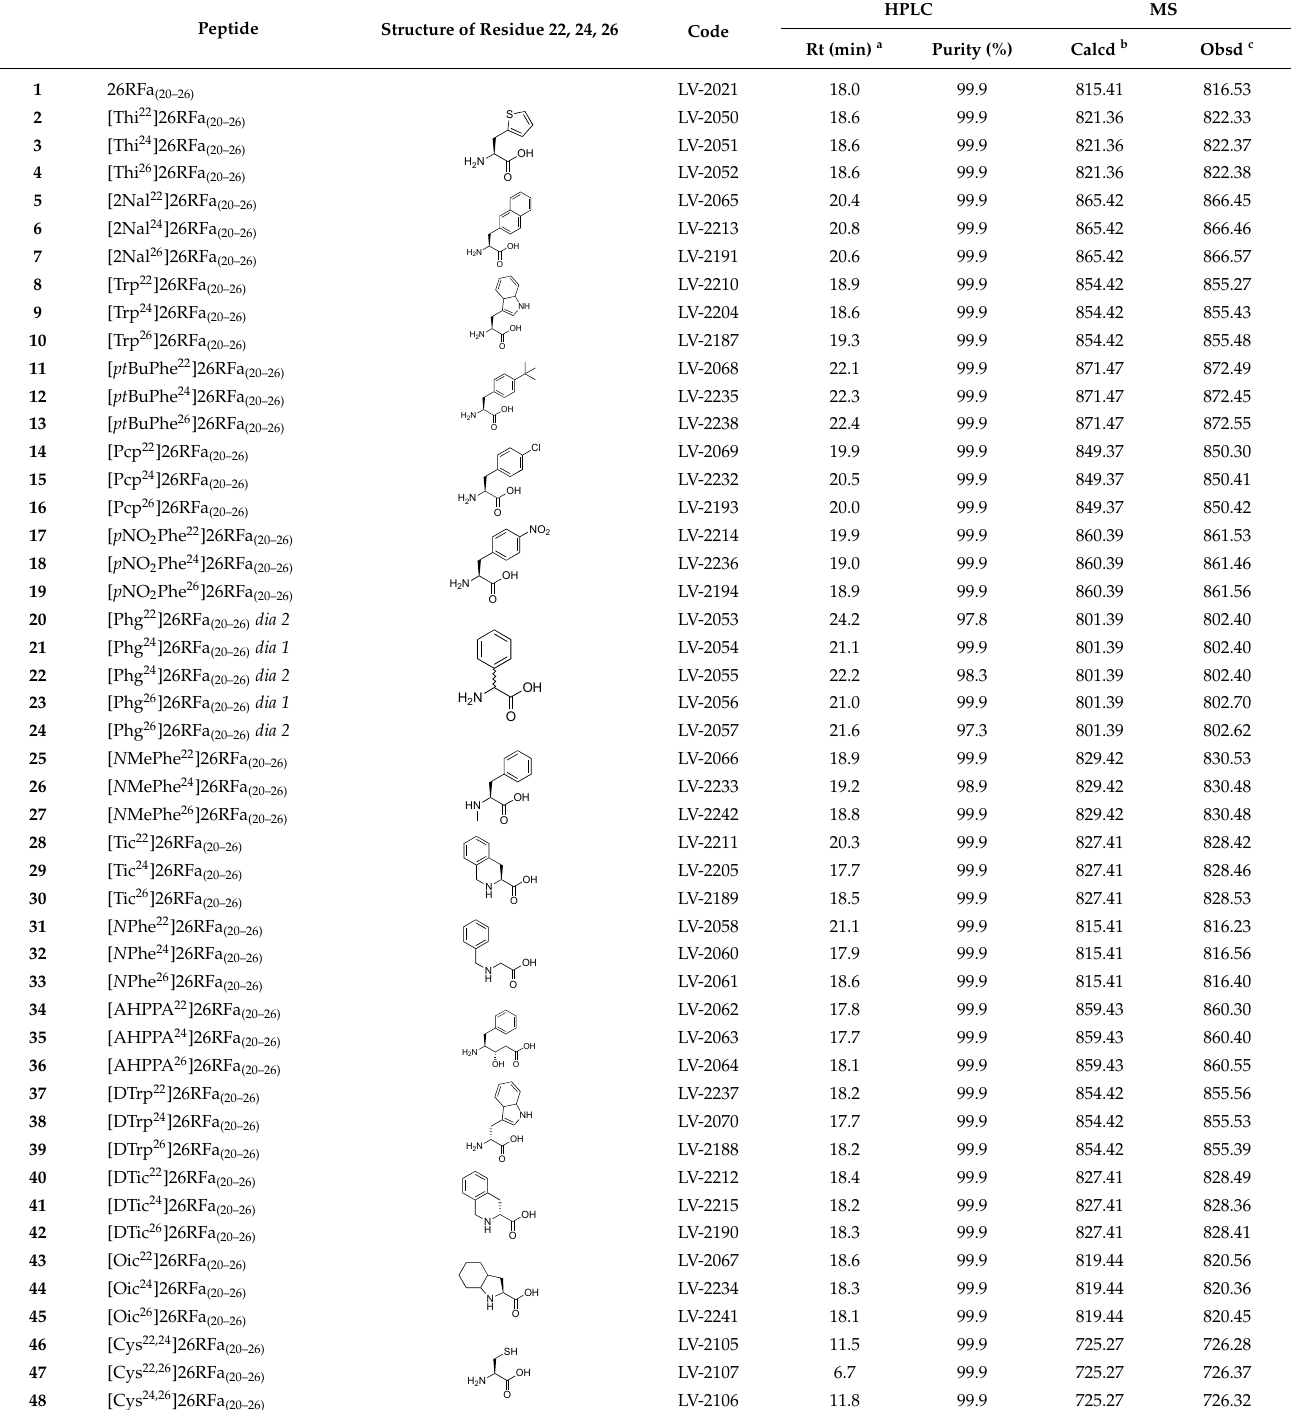
Table 1. Chemical data for 26RFa (20–26) analogs substituted in positions 22, 24 and 26. Peptide Structure of Residue 22, 24, 26